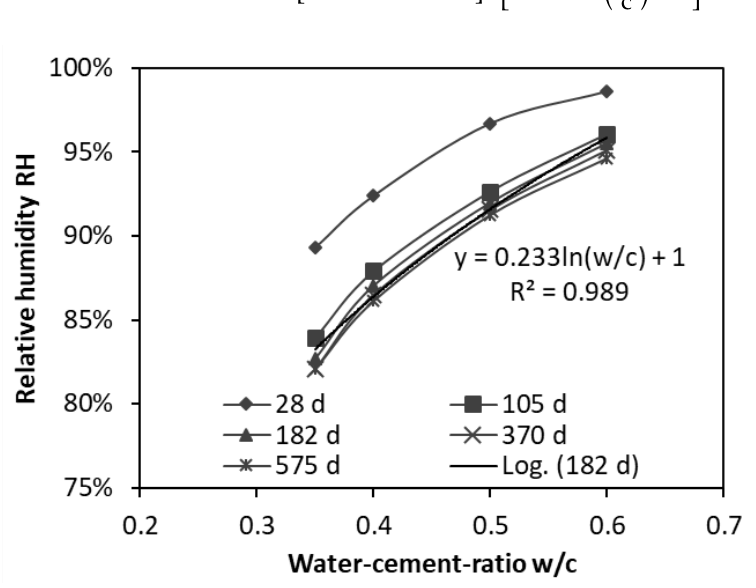
Figure 6. Effect of water-cement-ratio on time-related RH in OPC pastes. Figure 6. E ff ect of water-cement-ratio on time-related RH in OPC